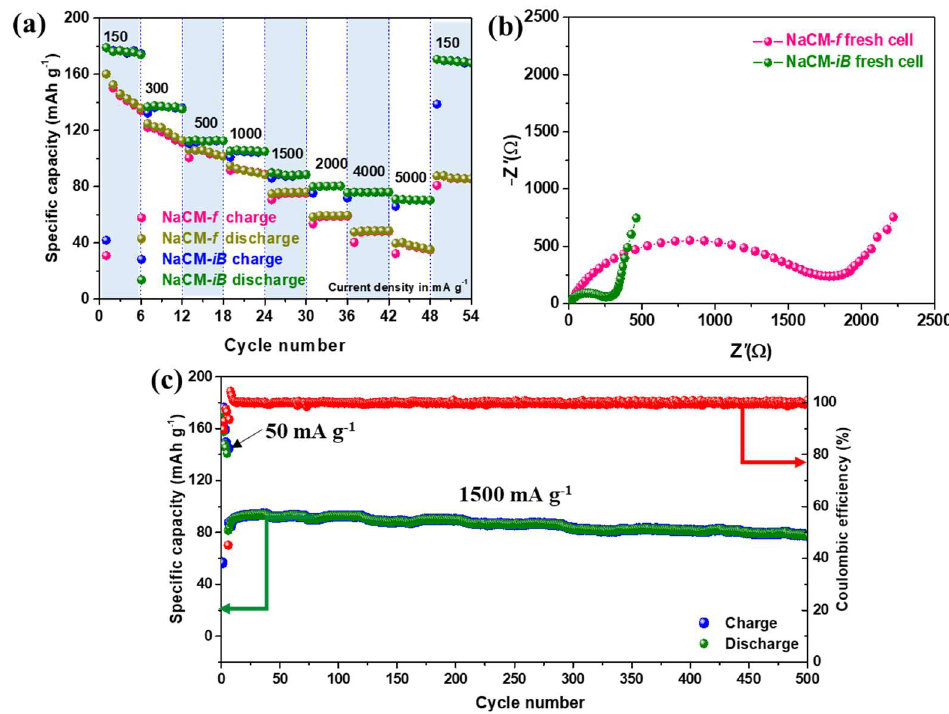
Figure 7. ( a ) Rate performance and ( b ) EIS spectra of the NaCM- iB and NaCM- f electrodes, ( c ) long-term cycling of the NaCM- iB cathode.